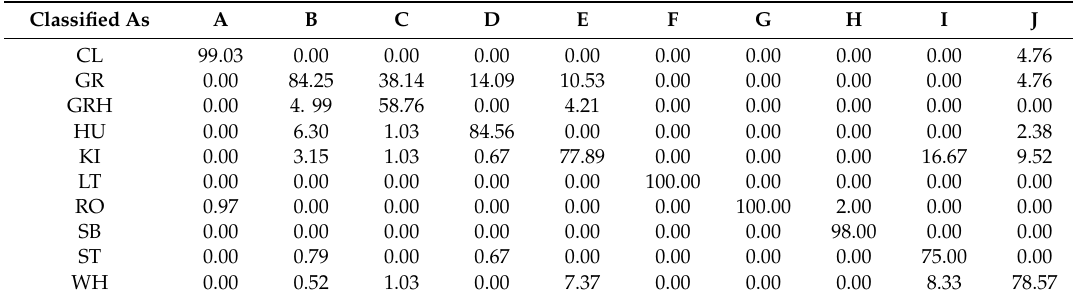
Table 3. Confusion Matrix on vocal type prediction. Cl: clacsons; GR: grunts; GRH: wheezing grunts; HU: hums; KI: kisses; LT: long tonal calls; RO: roars; SB: songbits; ST: short tonal calls; WH: